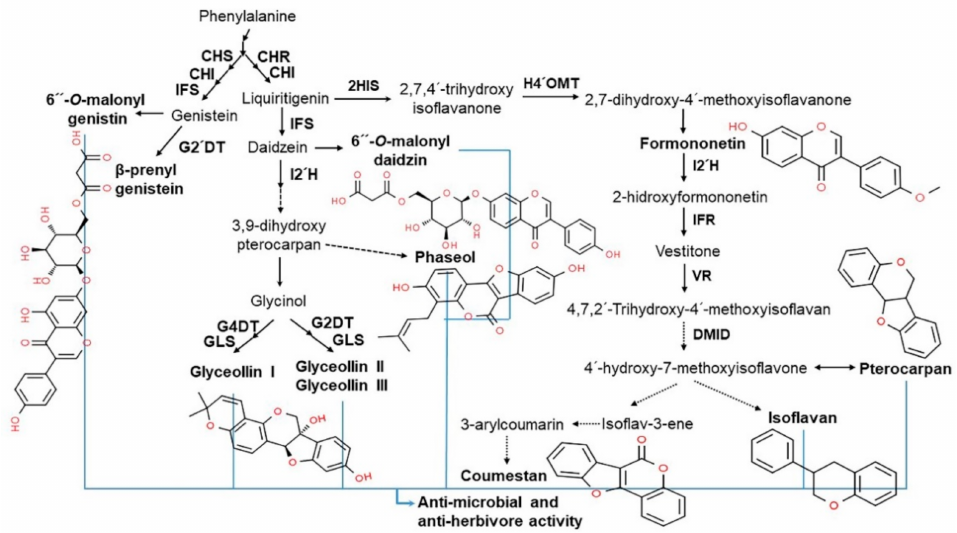
Figure 3. Relationship between isoflavone products and antimicrobial activity. Phenylalanine- derived biosynthetic isoflavone products, including 6”- O -malonylgenistein, glyceollins (I, II, and III), coumestan, isoflavan, and pterocarpan, are capable of antimicrobial and antiherbivore activity for defense against abiotic stress, such as pathogens